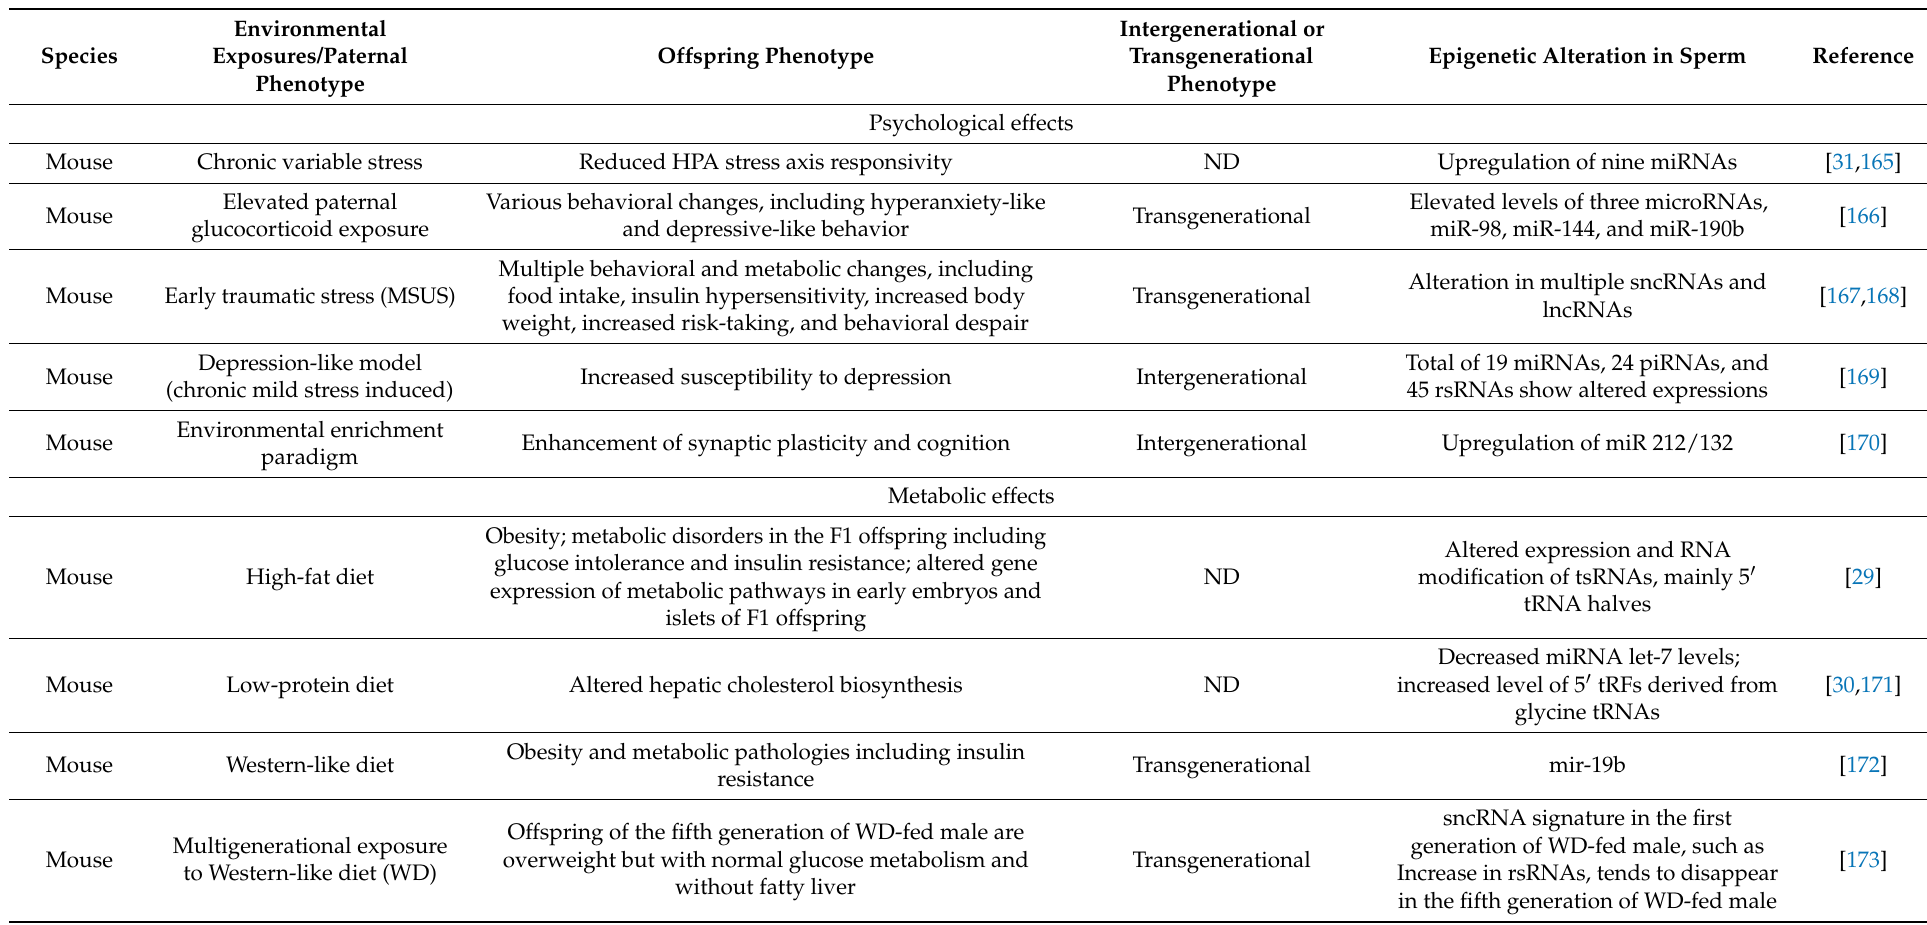
Table 1. Summary information of environmental exposure, altered sperm sncRNA profiles, and the influence on offspring. “ND” indicates transgenerational effects are not evaluated.